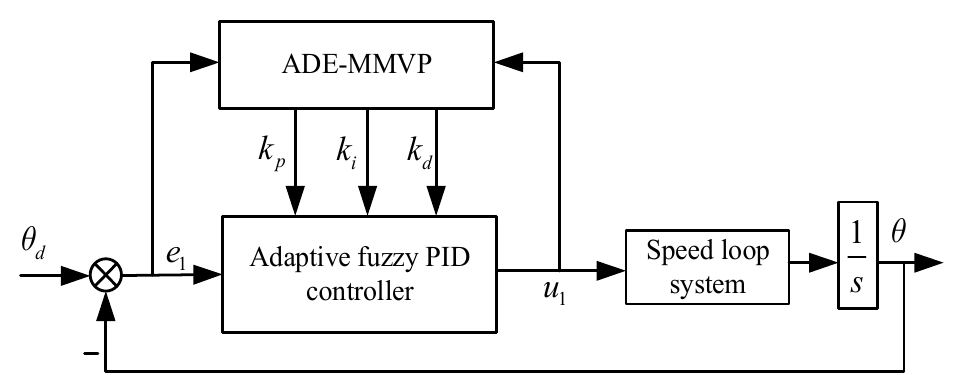
Figure 7. Structure of the position loop control system.